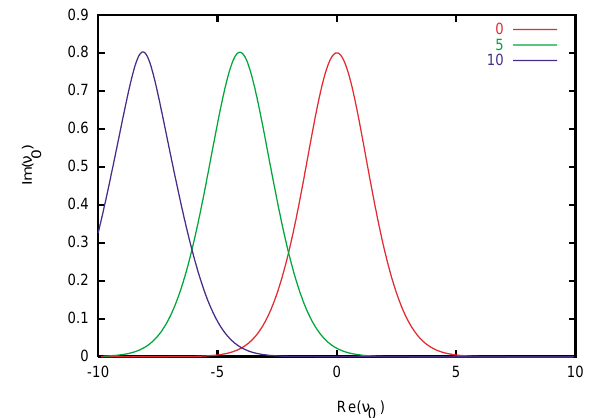
FIG. 6. (Color) Threshold diagrams for ten-term Gaussian series for k (cid:1) 0, 5, 10 with q (cid:6) k (cid:1) 3 (cid:6) 16 .